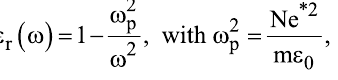
late charge is reduced. This provides more electrons as free carriers, making the system appear metallic. The analysis result is consistent with the analysis result of the energy band struc-